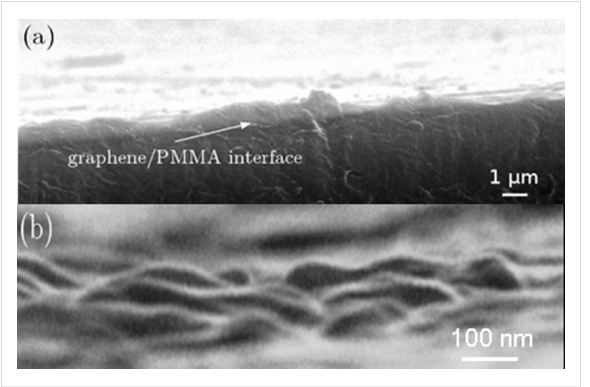
Figure 1: (a) SEM images of the slat section of the graphene/PMMA interface; (b) SEM image of the graphene surface at high magnifica-